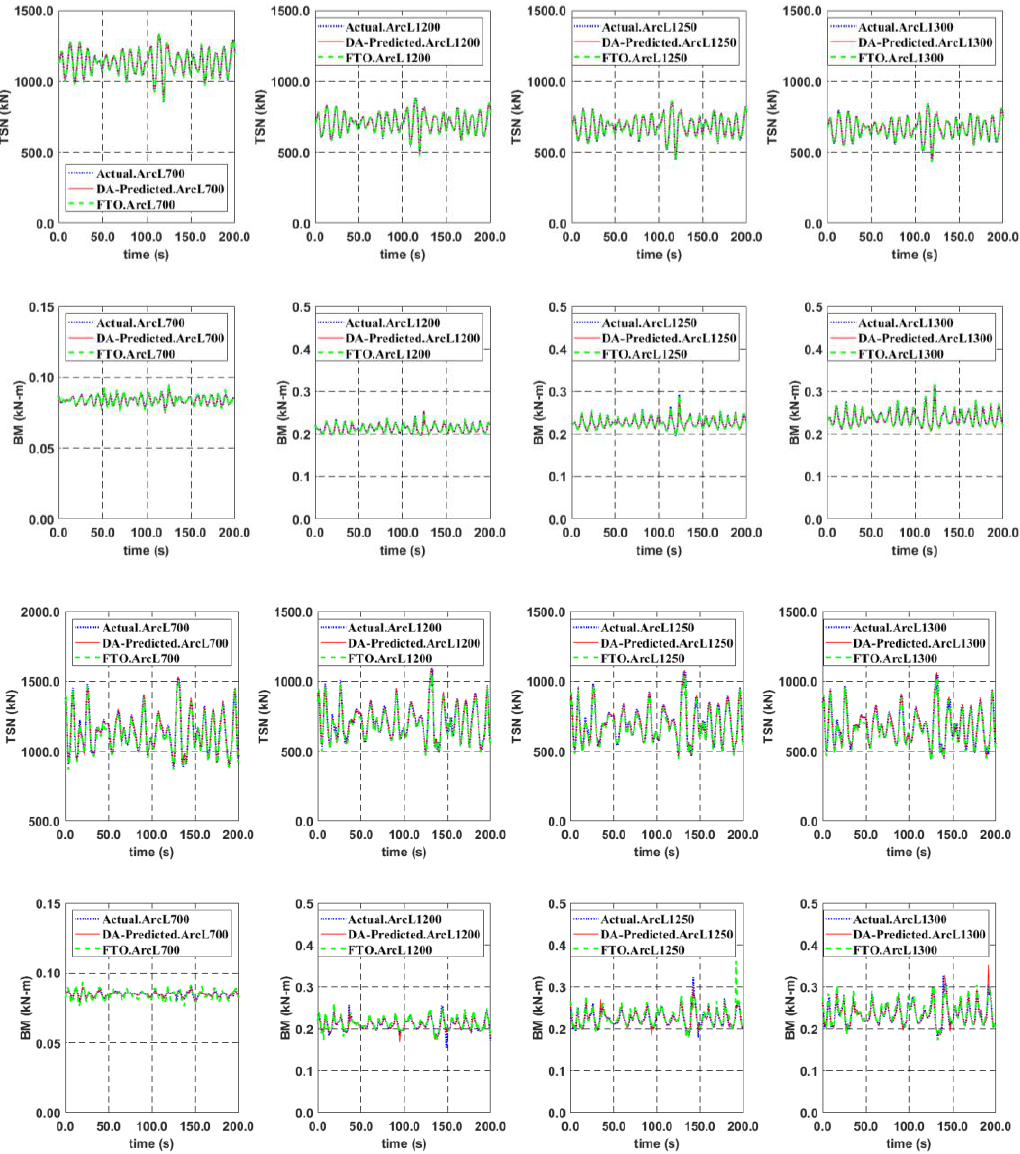
Figure 13. Structural-Health Monitoring Performance Comparison Near Touch Down Zone (= Arclength 1150–1250 m) and Near Mid-Length (700 m) between DA and FTO Approaches: 1-yr Storm ( Up ) and 100-yr Storm ( Down ), WD1000, SCR, Sensors at 0 m, 100 m, and 200 m Arc Lengths